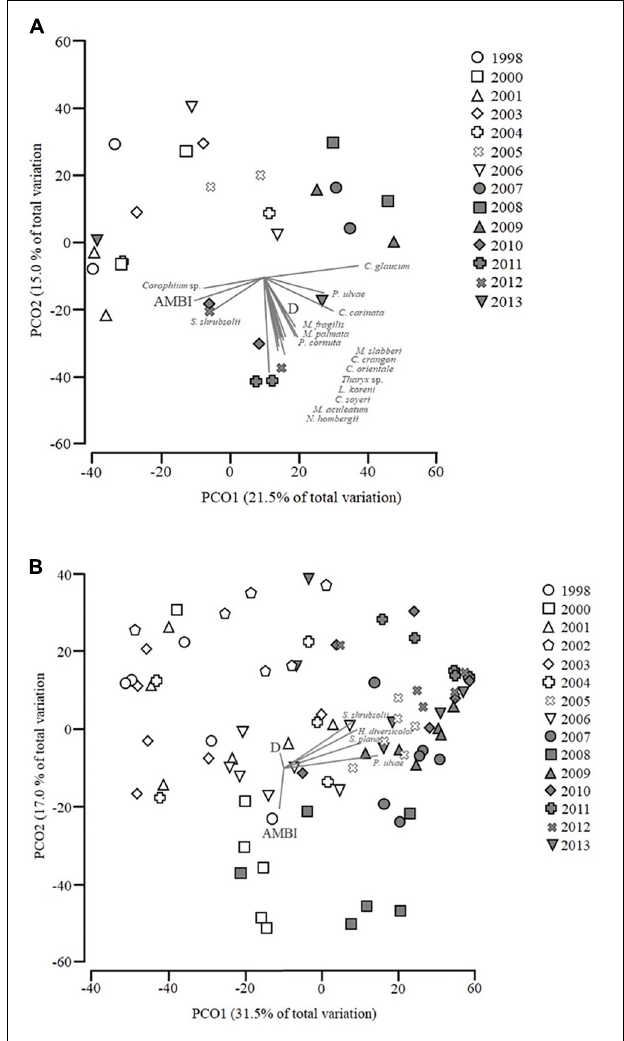
FIGURE 5 | (A) Principal coordinates analysis (PCoA) of soft bottom macrobenthic communities within Parque das Nações Subtidal (PNS). Correlation with AZTI’s Marine Biotic Index (AMBI) and Distribution (D) are shown as well as species which have a Pearson correlation of at least 0.4 with PCO1 or PCO2. (B) PCoA of soft bottom macrobenthic communities within Parque das Nações Intertidal (PNI). Correlation with AZTI’s Marine Biotic Index (AMBI) and Distribution (D) are shown as well as species which have a Pearson correlation of at least 0.3 with PCO1 or PCO2.